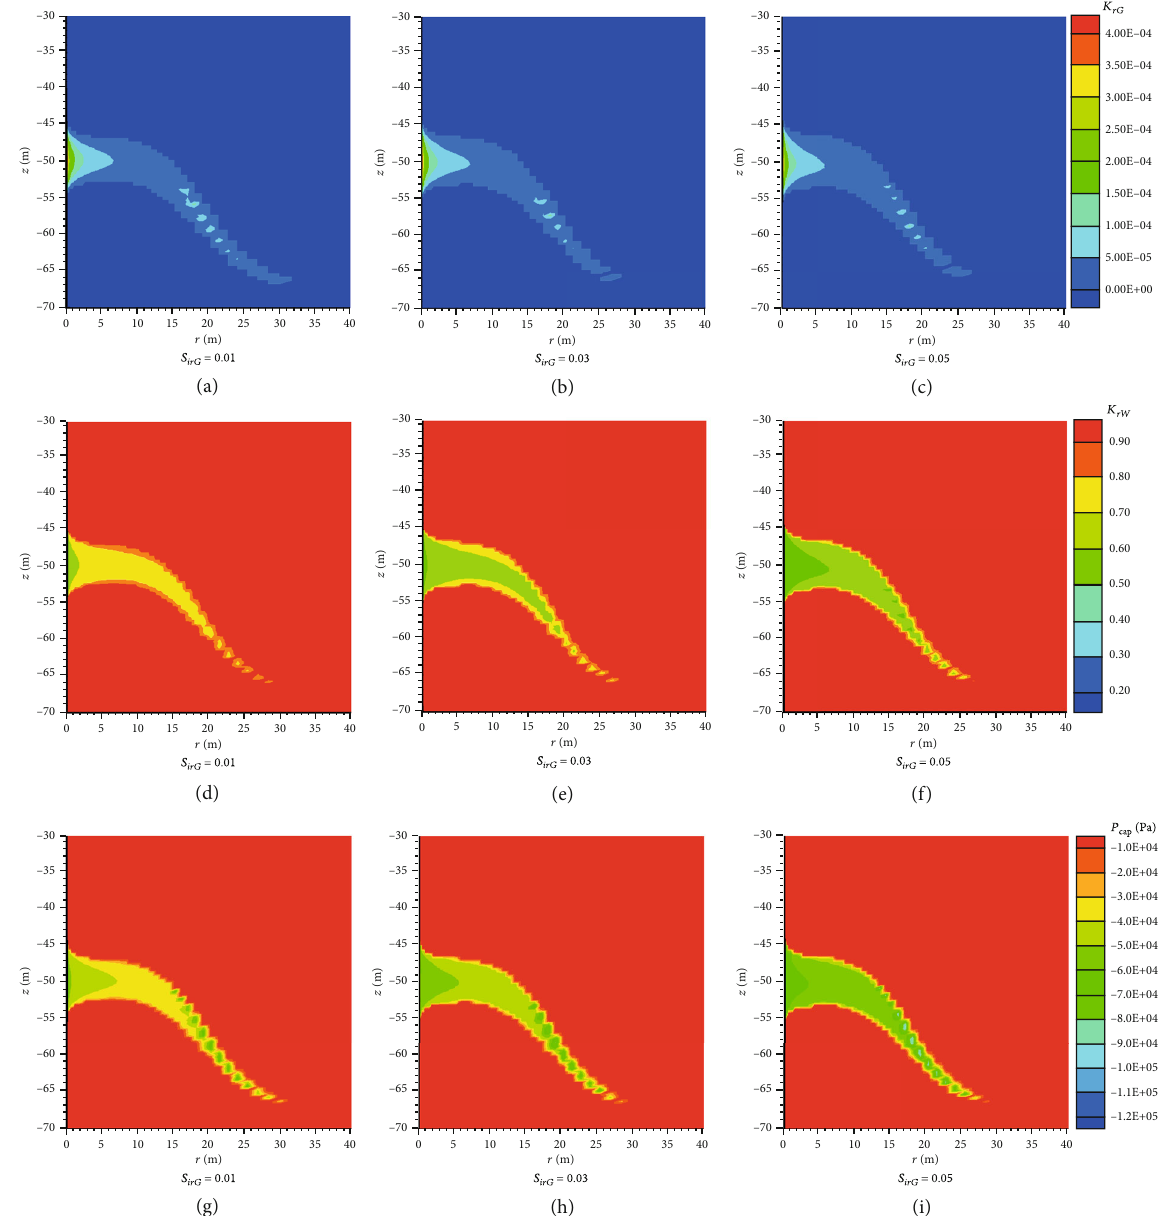
Figure 14: Comparison of gas relative permeability K with di ff erent irreducible gas saturation S